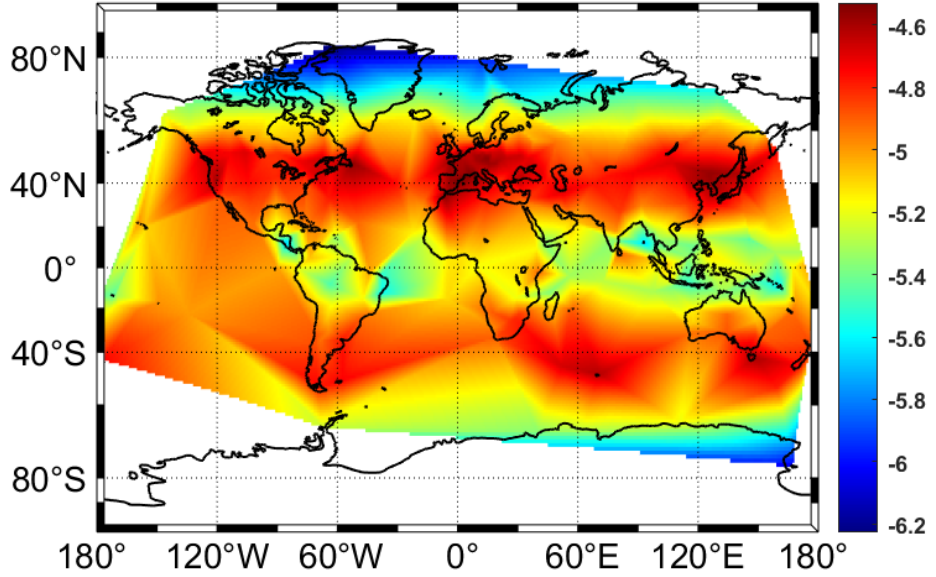
Figure 8. Means of the mapping coefficient between dZTD and the SPP biases on the vertical direction at globally distributed IGS stations.